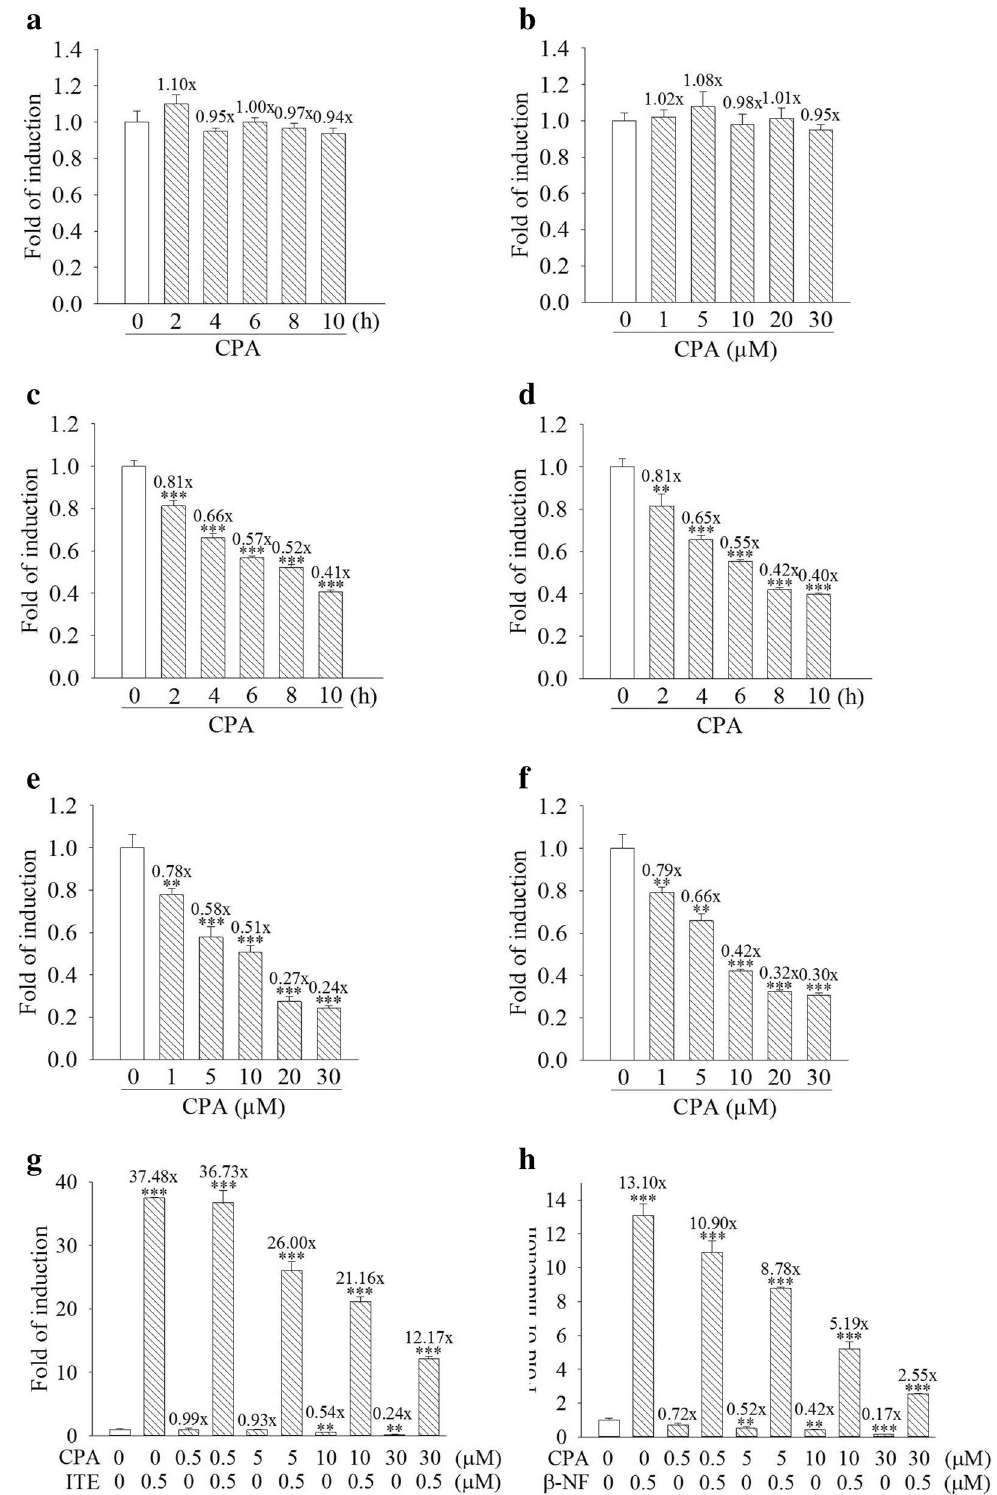
Figure 8. Effect of cyproterone acetate (CPA) on the transactivation activity of the aryl hydrocarbon response element (AHRE) in human cells. Reporter plasmids, ( a , b ) pTAL-Luc and RSV- lac Z or ( c-h ) pAhRDtkLuc3 and RSV- lac Z, were transient transfected into HepG2 and MCF7 cells for 18 h, and then cells were treated with the test compounds. ( a ) HepG2 cells were treated with CPA (10 μM) for 2–10 h. ( b ) HepG2 cells were treated with CPA (1–30 μM) for 6 h. ( c , d ) HepG2 and MCF7 cells were treated with CPA (10 μM) for 2–10 h. ( e , f ) HepG2 and MCF7 cells were treated with CPA (1–30 μM) for 6 h. ( g , h ) HepG2 cells were pretreated 0.5–30 μM CPA for 1 h, followed by treatment with 0.5 μM ITE for 6 h and 0.5 μM β-NF for 9 h respectively. At the end of incubation with the test compounds, cells were harvested and cell lysates were collected for an activity assay of luciferase and β-galactosidase. Results are expressed as the mean ± SD, n = 3. ** p < 0.01, and *** p <